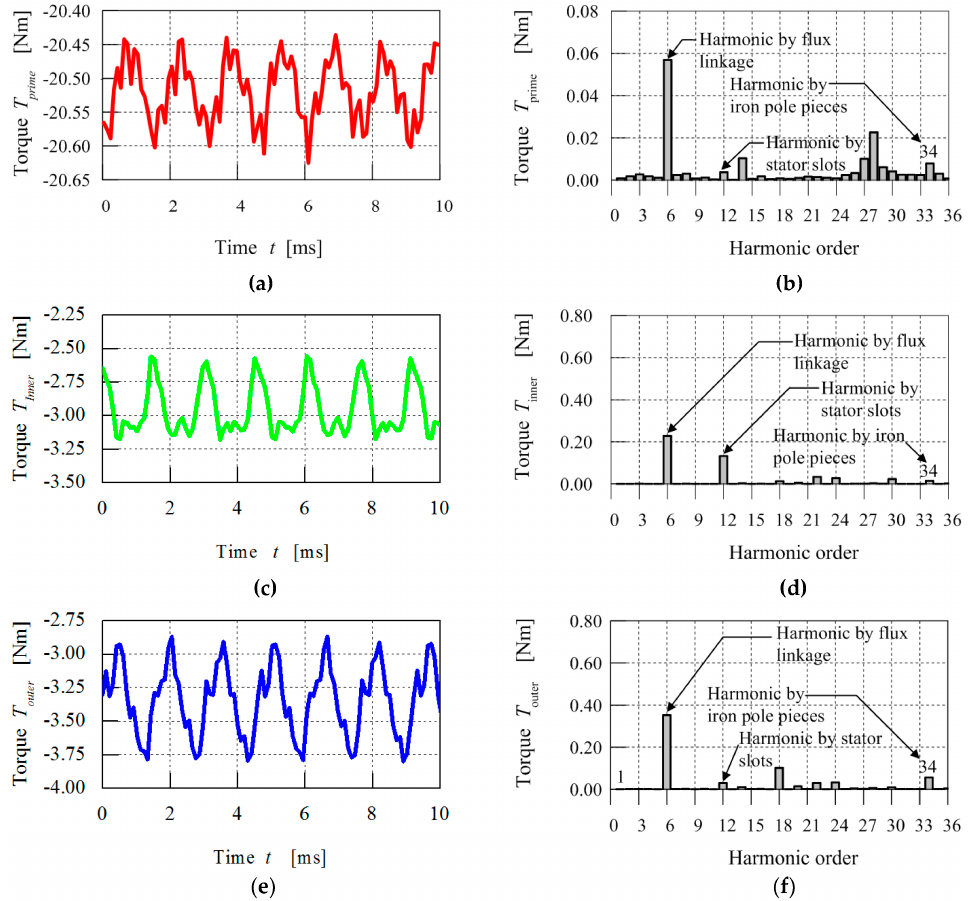
Figure 14. The ripple torque characteristics of the DS-MGM: ( a ) Prime PM rotor ripple torque; ( b ) Harmonic analysis of ( a ); ( c ) Inner PM rotor ripple torque; ( d ) Harmonic analysis of ( c ); ( e ) Outer PM rotor ripple torque; ( f ) Harmonic analysis of ( d ).